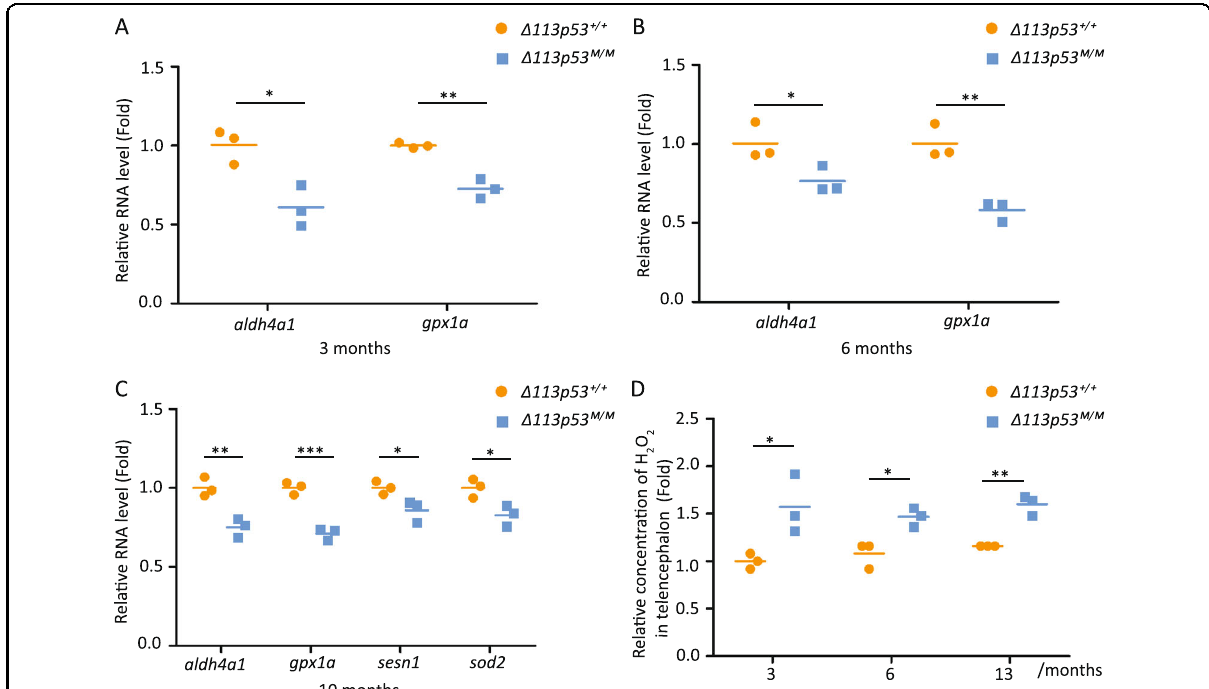
Fig. 3 Depletion of Δ 113p53 results in an elevated level of intracellular H 2 O 2 in zebra fi sh telencephalons. A – C Relative mRNA expression of aldh4a1, gpx1a, sesn1, sod2 at 3- ( A ), 6- ( B ), and 10-months old ( C ) in the Δ 113p53 + / + or Δ 113p53 M/M telencephalons. The total RNA was extracted from a pool of at least six telencephalons in each group. The average gene expression was normalized against β -actin and expressed as fold change. D The relative concentration of H 2 O 2 in the Δ 113p53 + / + and Δ 113p53 M/M telencephalons at 3-, 6-, and 13-months old as indicated. Each group was measured based on a pool of at least four telencephalons. Statistical analysis was performed on relevant data using the Student ’ s two-tailed t test. * P < 0.05, ** P < 0.01, *** P <